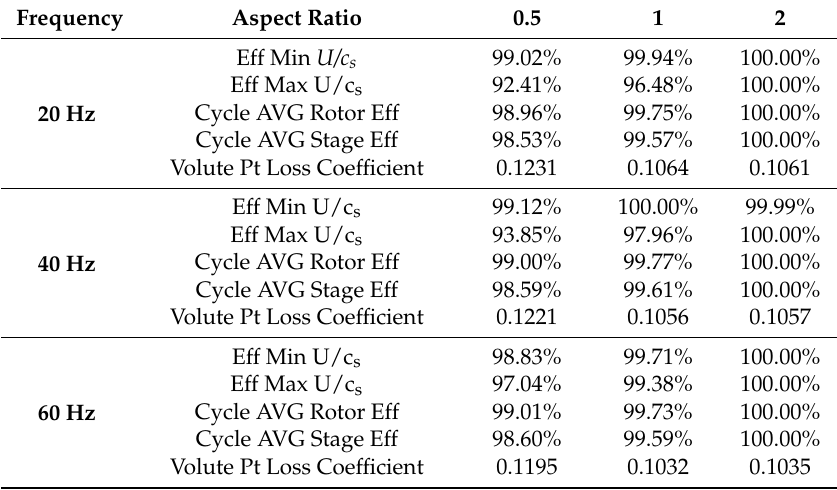
Table 1. Normalized performance of each aspect ratio housing design at 20 Hz, 40 Hz and 60 Hz pulse frequency.